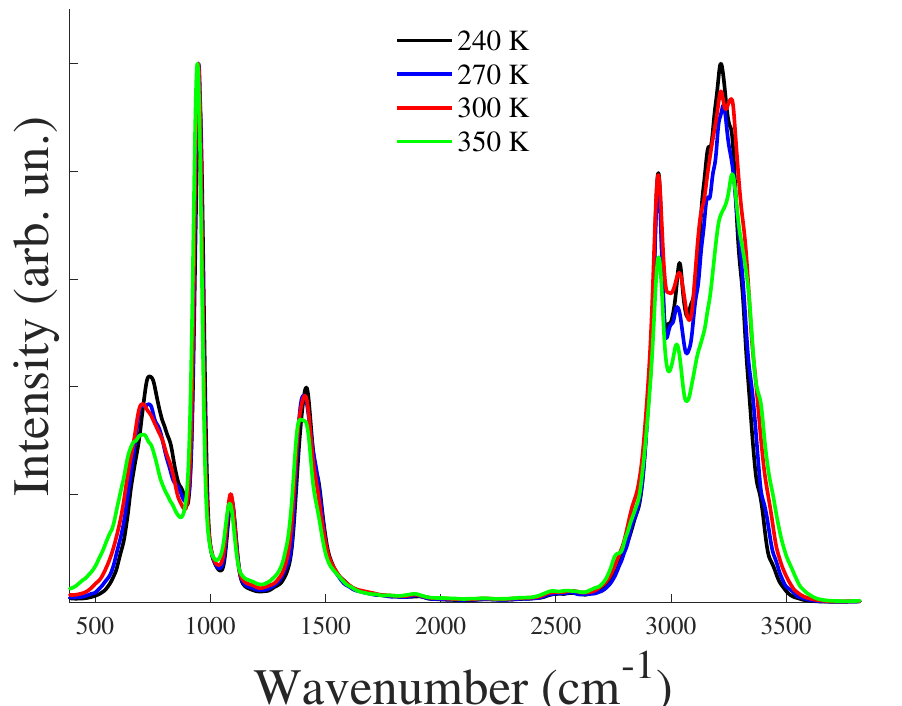
Figure 3. IR absorption spectra of bulk liquid methanol determined at 240 K (black line), 270 K (blue line), 300 K (red line), and 350 K (green line) in absence of electric field. Notice that the red-line curve coincides with the red-line curve of Figure 2 and with the black-line curve of Figure 1 (i.e., T = 300 K and E = 0.00 V/Å).